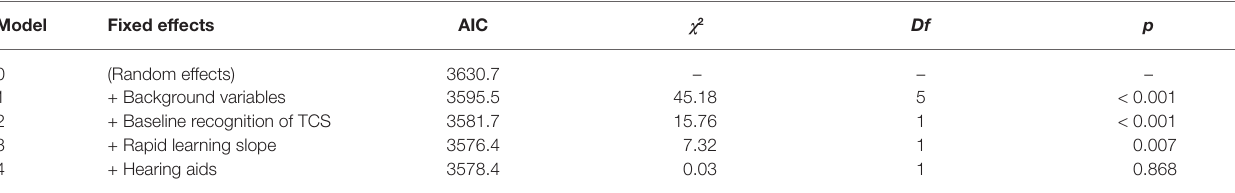
TABLE 4 | Fast speech—model